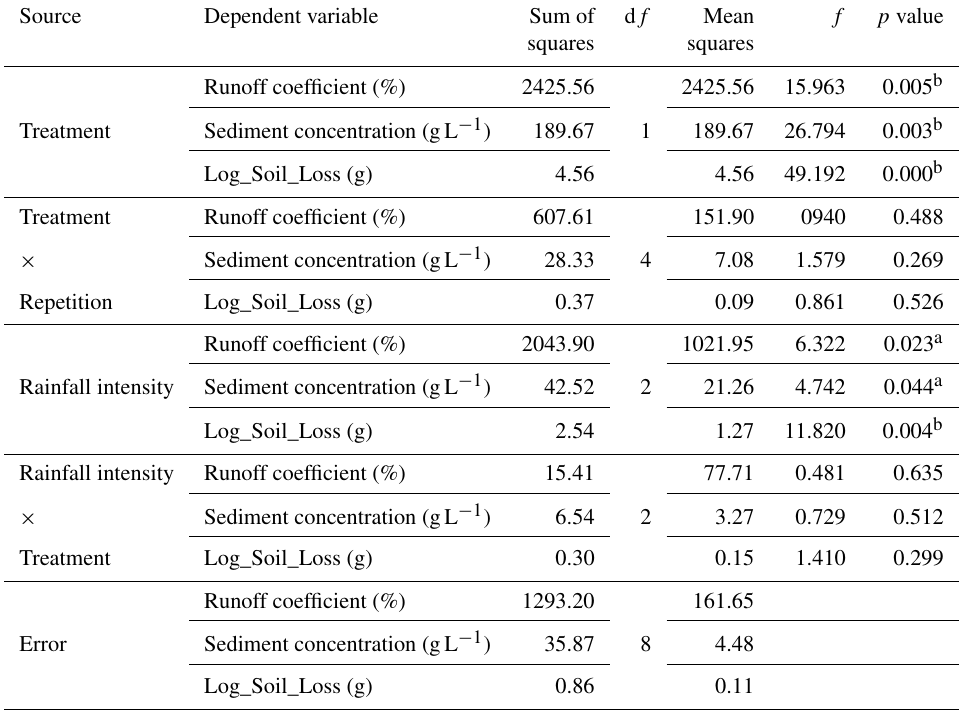
Table 4. Statistical analysis of the effects of soil preparation treatment and rainfall intensity on sediment concentration and soil loss. Source Dependent variable Sum of